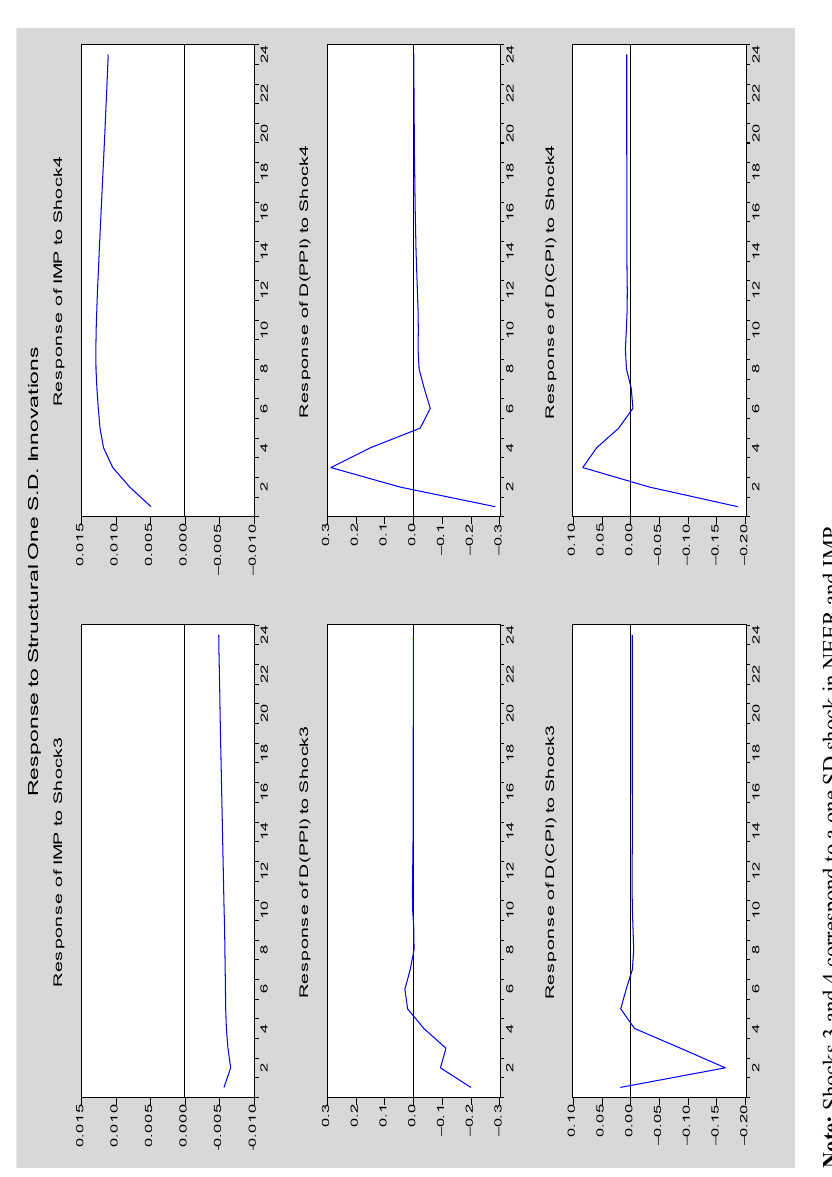
Figure 6. Impulse responses for IMP, PPI and CPI; extended experiment: monetary